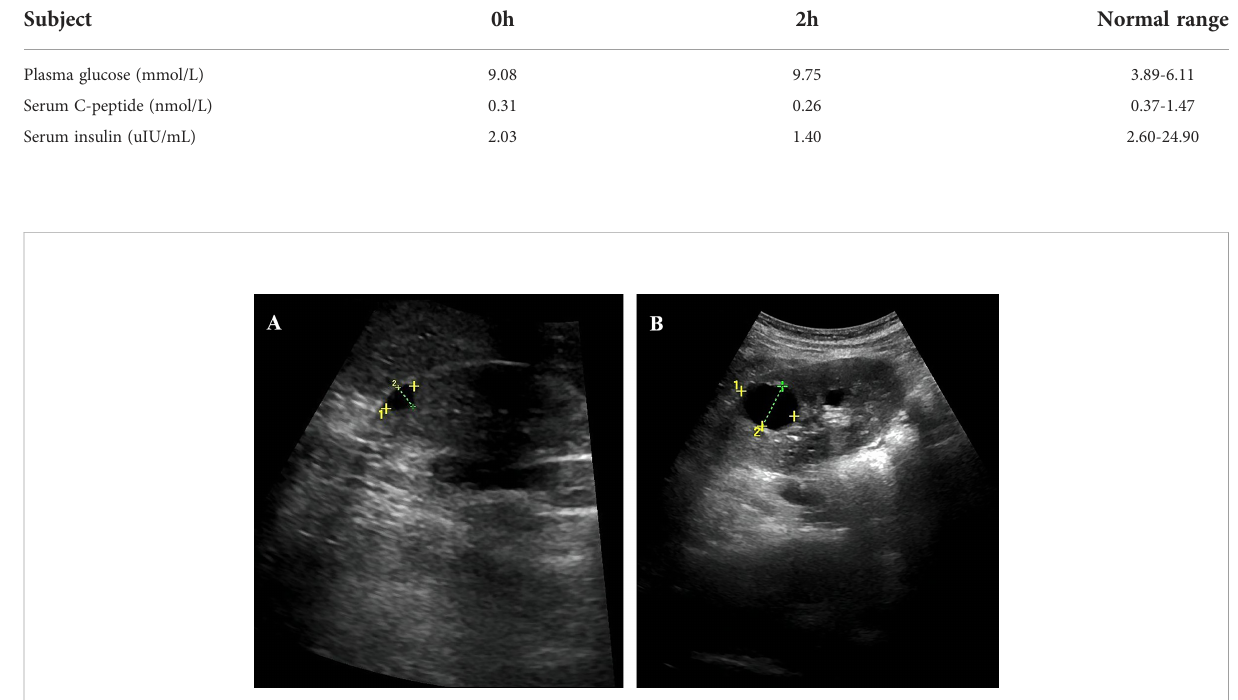
TABLE 2 Fasting and 2-hour postprandial metabolic indicators.